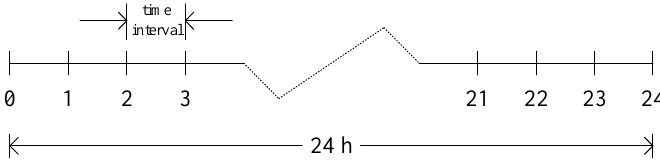
Figure 6. Discrete-time representation of the DR scheme.